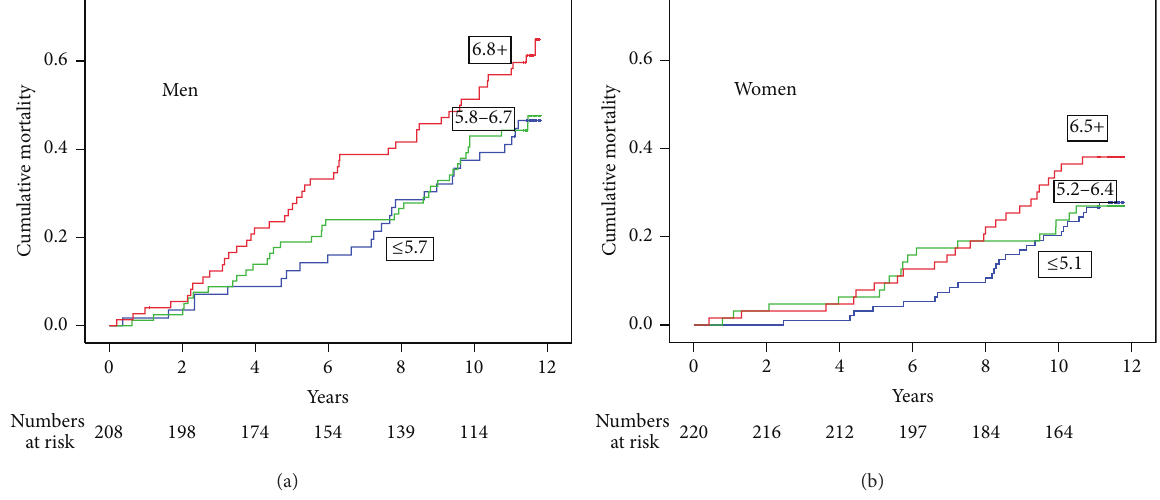
Figure 1: Kaplan-Meier curves showing cumulative all-cause mortality according to sex-specific WBC count tertiles.